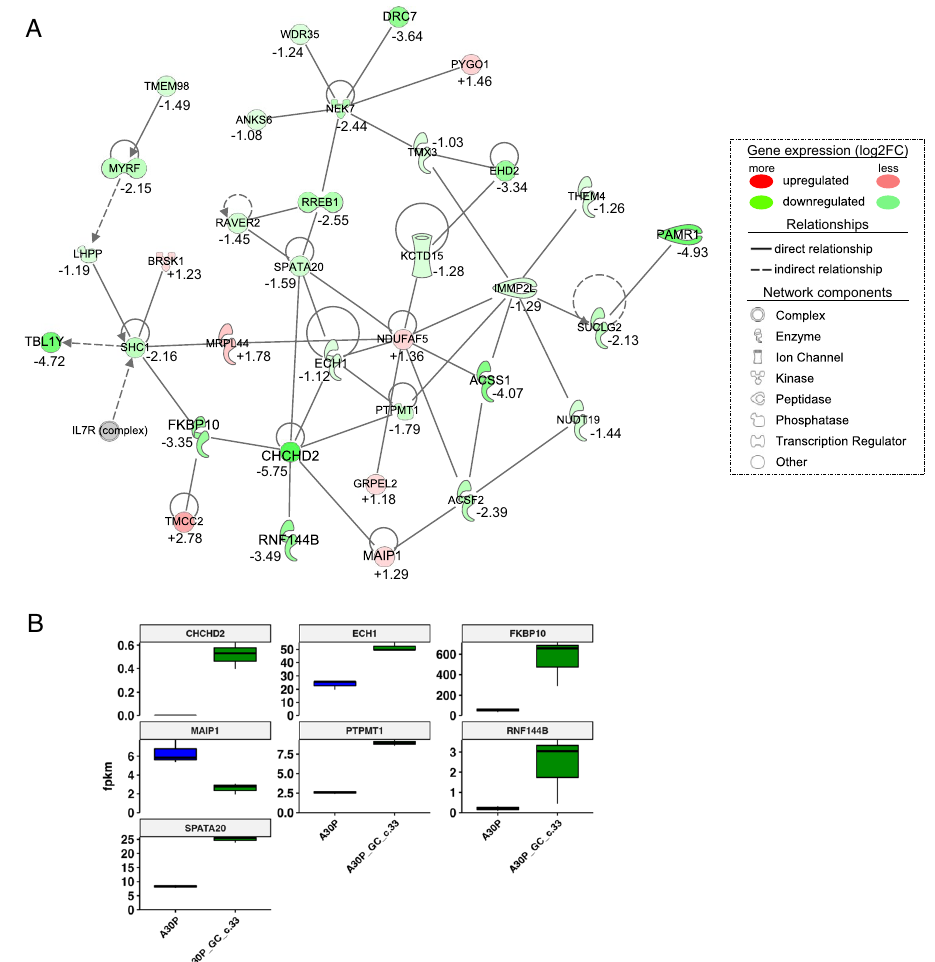
Figure 5. Functional analysis of gene expression networks performed by Ingenuity Pathway Analysis (IPA). ( A ) Changes in genes associated with lipid metabolism. Genes in green are upregulated, and in red downregulated in respect to the patient neurons compared to the gene-corrected isogenic control ( B ) Gene expression levels based on RNA-seq of the genes associated with lipid